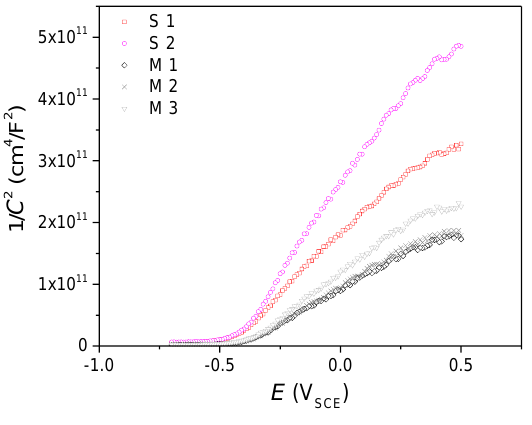
Figure 9. Mott–Schottky plots.